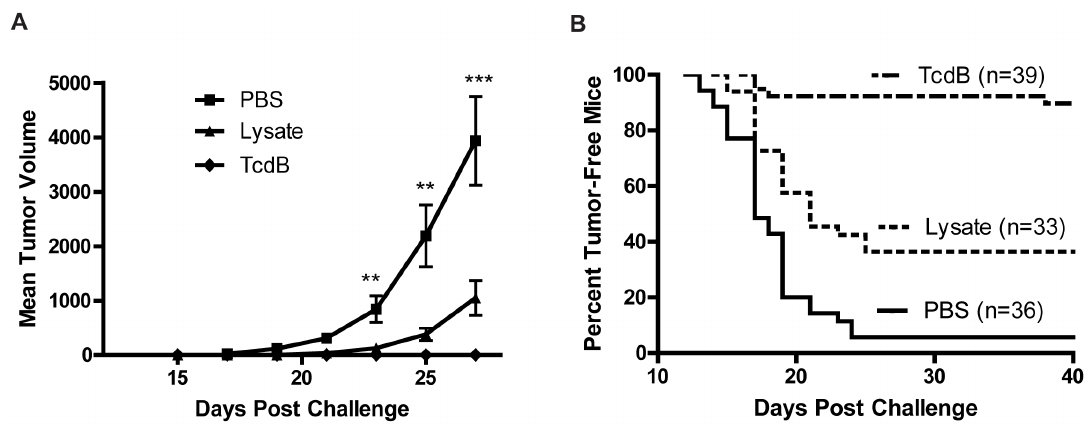
Figure 3. Anti-tumor immunity induced by dying CT26 cells. Mice were subcutaneously immunized with PBS or TcdB-exposed CT26 cells (TcdB). In some experiments, mice were injected with lysate of TcdB-treated CT26 cells (TcdB-lysate). Mice were then challenged with 10 5 live CT26 cells on the opposite side of the groin and tumor growth was monitored. (A) Tumor volume was calculated using the formula: length 6 width 2 6 p /6. The data represent one of five independent experiments (n=5 , 8). **, P , 0.01 vs. PBS; ***, P , 0.001 vs. PBS (paired two-tailed t- test). Error bars, SEM. (B) The percentage of tumor-free mice was measured. The data in (B) represent a pool from five independent experiments (n=5 , 8 for each